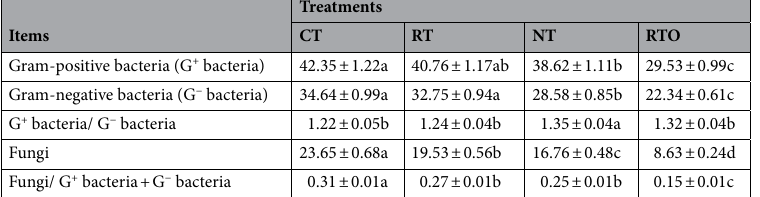
Table 3. PLFAs (μg g -1 ) in Gram-positive bacteria (G + bacteria), Gram-negative bacteria (G − bacteria), fungi and the ratio among them with different tillage treatments.